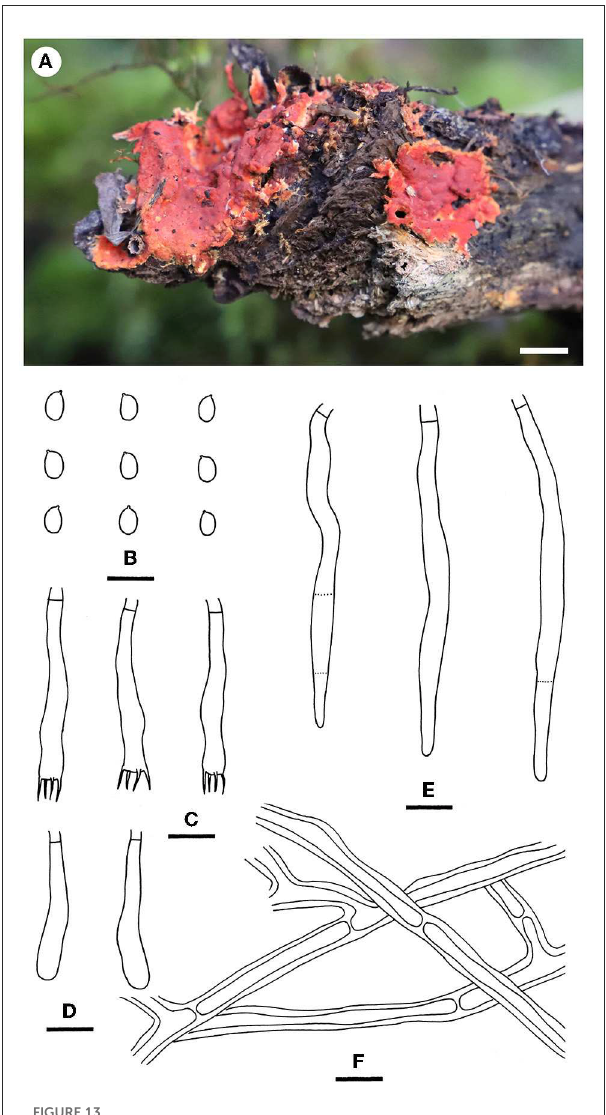
FIGURE13 Phanerochaete subsanguinea [from He 6131; scale bars: (A) = 1cm; (B–F) = 10 µ m]. (A) Basidiomes; (B) Basidiospores; (C) Basidia; (D) Basidioles; (E) Cystidia; (F) Hyphae from subiculum.